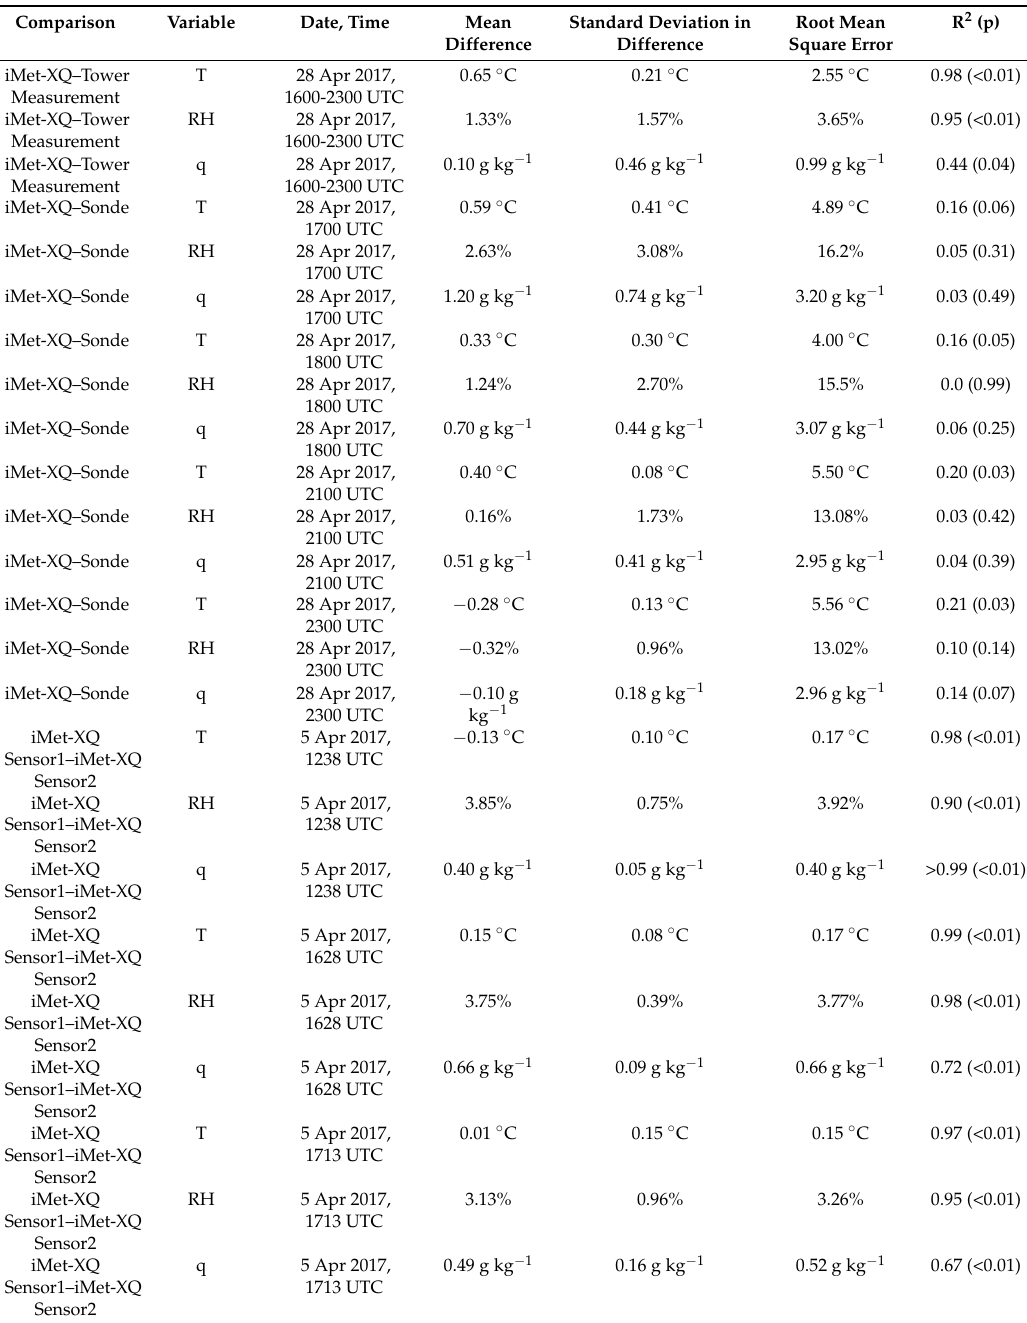
Table 4. Summary statistics on the inter-comparisons shown in the present study between the iMet-XQ sensors’ measurements of temperature (T), relative humidity (RH), and specific humidity (q) and measurements from: (1) A 10-m micrometeorological tower, (2) rawinsondes, (3) iMet-XQ sensors on the same sUAS platform, and (4) iMet-XQ sensors on different sUAS platforms. In the table below the, mean difference, standard deviation in the difference, root mean square error, R 2 , p -value, and number of cases are reported. When comparing the iMet-XQ measurements with the tower measurements, the means of the data ± 15 min from the time of the sUAS flight were used for computing the statistics reported below. For all other comparisons, the means were computed in 10-m height bins and used to calculate the statistics reported